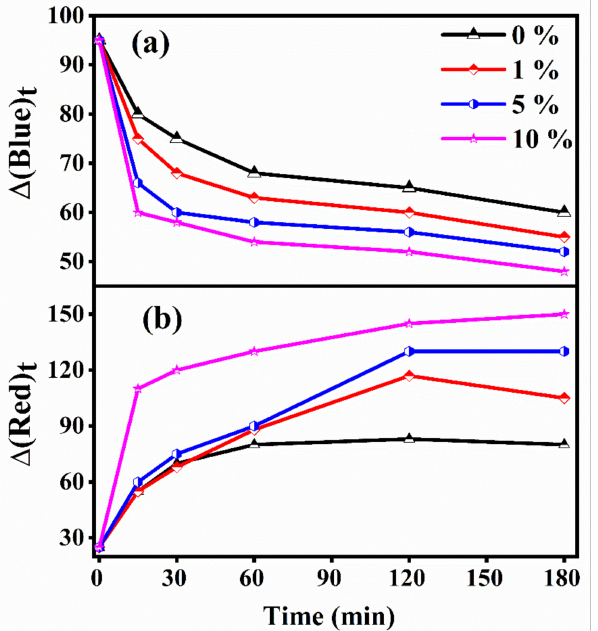
Figure 6. ∆ RGB’t vs. time plots for ( a ) blue and ( b ) red color change due to photo-reduction inRz indicator ink on POP–BiF 3 (%) composites having BiF 3 0%, 1%, 5%, and 10% by wt., respectively, under the UV light